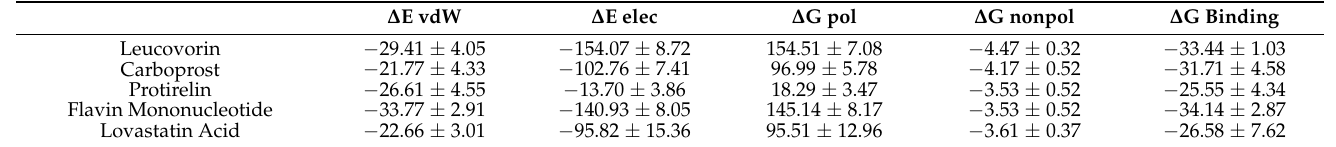
Table 4. Gibbs binding free energy (Kcal/mol) of the five hypothetical inhibitors with pS273R calculated using MM/PBSA.